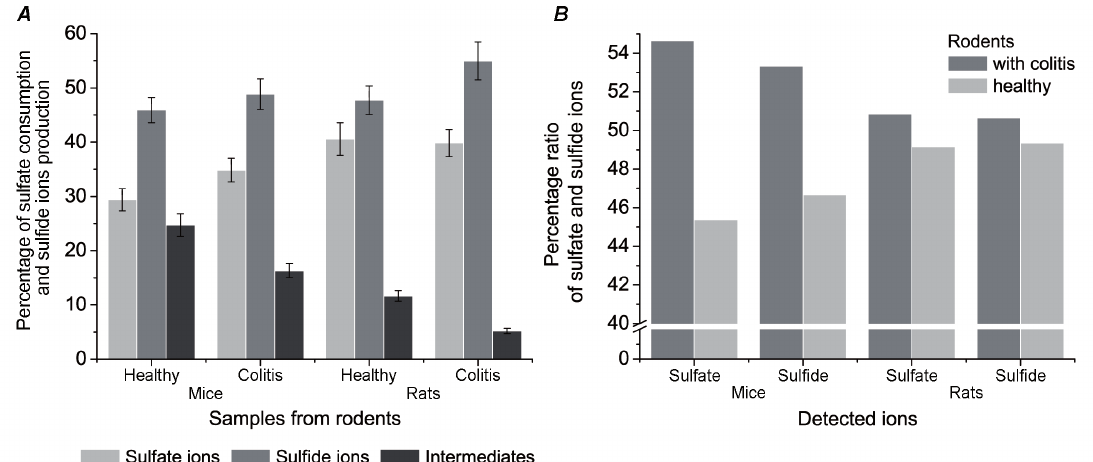
Figure 2: Percentage ratio of sulfate reduction ions (A), the percentage of starting and final metabolites during sulfate-reduction (B) from healthy samples and samples with UC.